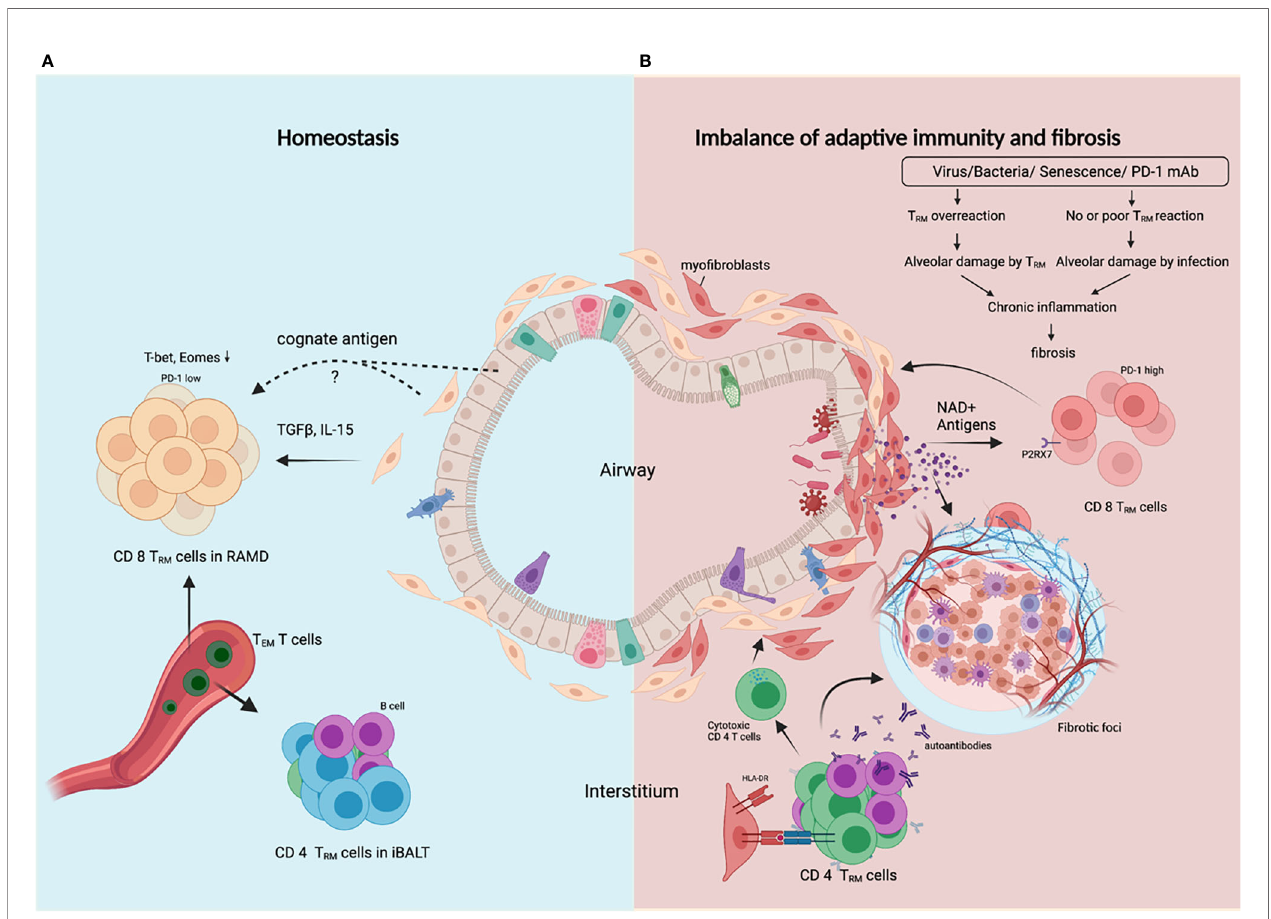
FIGURE 2 | T RM cells control the balance between protective adaptive immunity and progressive fi brosis. (A) In homeostasis following resolution of lung infection or injury, CD8 T RM cells and CD4 T RM cells are generated and transiently maintained in RAMD and iBALT respectively, and can be replenished by T EM cells from the bloodstream. T RM cells are poised to render robust protection against secondary infection or injury, and ensure subsequent rapid tissue repair. (B) In fi brosing lung, dysregulated CD8 T RM cells in response to certain external insults lead to constant alveolar damage, subsequent chronic in fl ammation and progressive fi brosis. Alveolar damage release high level of NAD + which selectively delete P2RX7 + T RM cells. CD4 T RM cells in iBALT may help B cells generate autoantibodies, or become cytotoxic or regulatory CD4 T cells that worsen tissue injury and fi brosis. Created with